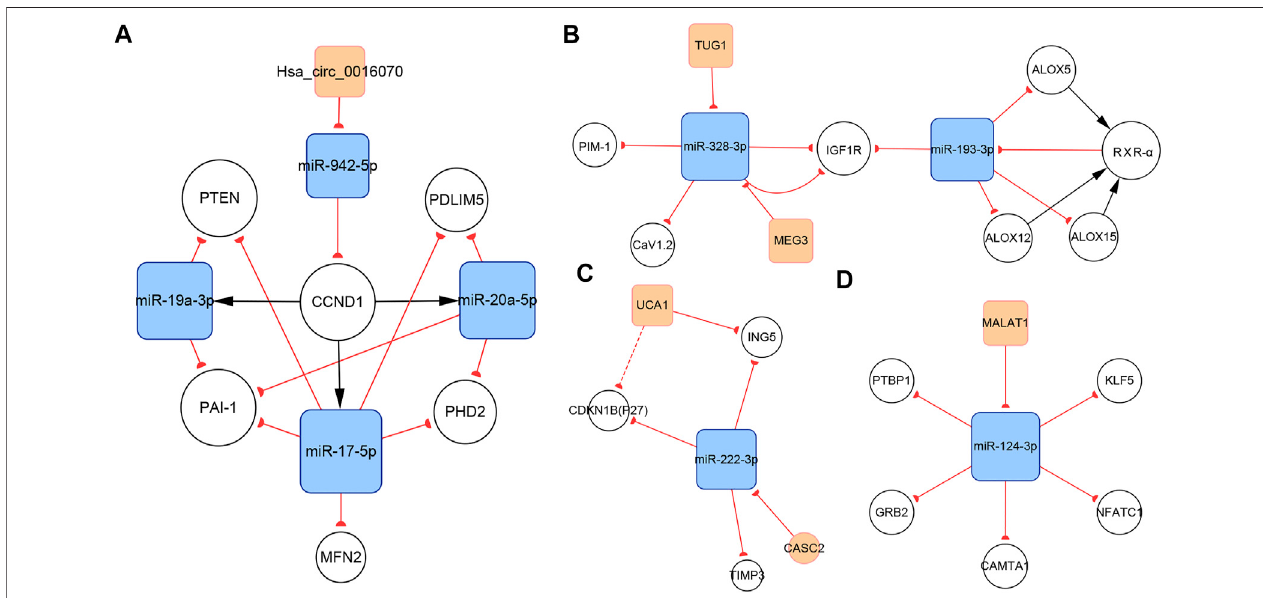
FIGURE 7 | Several key ncRNA subnetworks. (A) The hsa_circ_0016070/miR-942-5p/CCND1 subnetwork. (B) The TUG1/MEG3/miR-328-3p/miR-193-3p subnetwork. (C) The CASC2/UCA1/miR-222-3p subnetwork. (D) The MALAT1/miR-124-3p subnetwork.